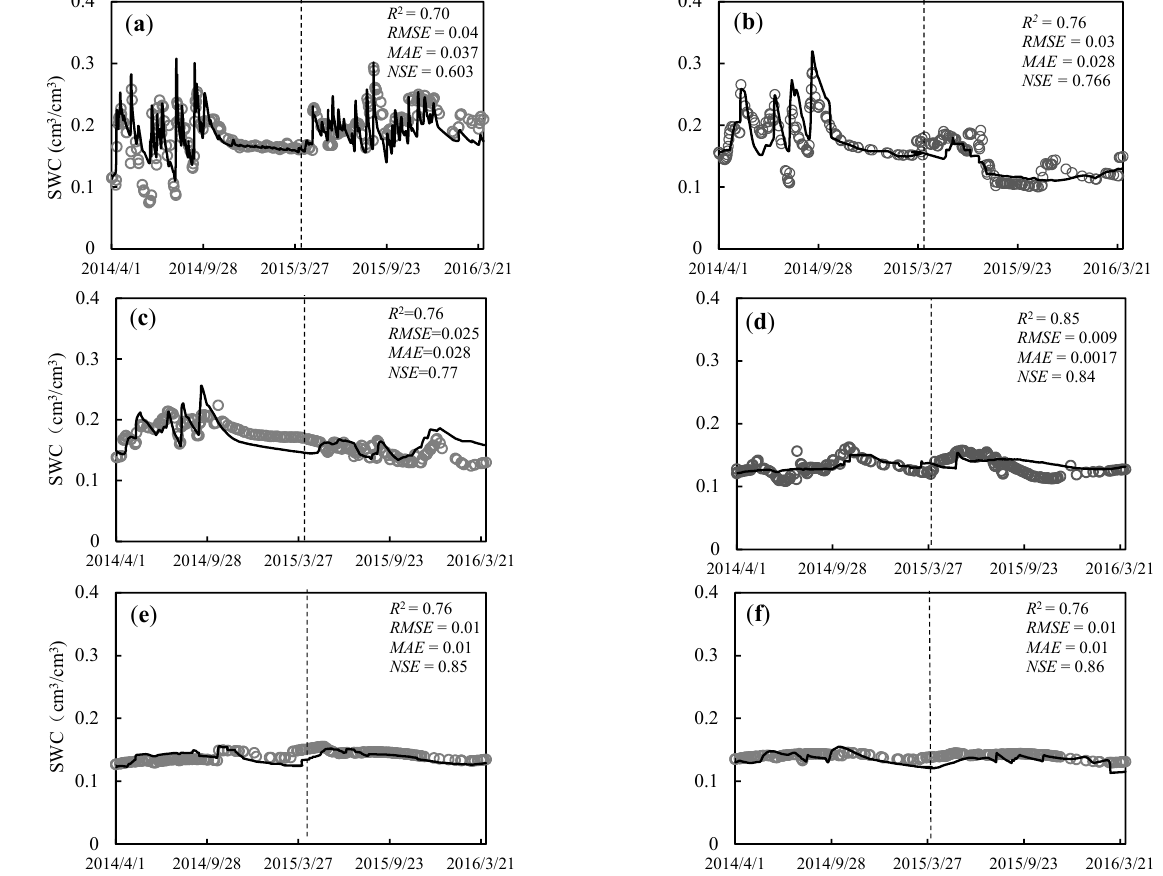
Figure 5. Comparison of the simulated and observed soil water contents at typical soil depths. The hollow circles represent the measured soil water contents, and the solid lines represent the simulated soil water contents. SWC is soil water content: ( a ) 20 cm, ( b ) 50 cm, ( c ) 80 cm, ( d ) 120 cm, ( e ) 160 cm, ( f ) 200 cm.